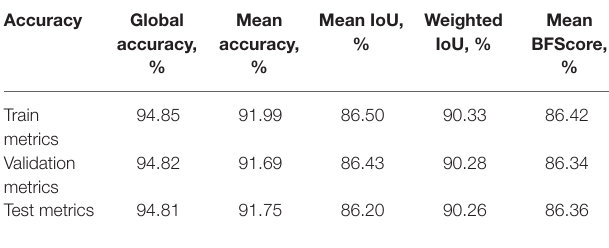
TABLE 7 | The performance metrics for image